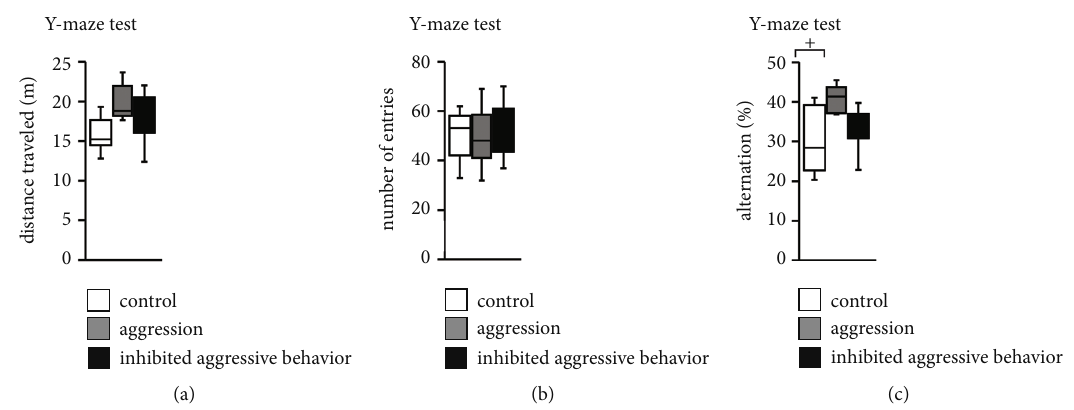
Figure 4: Performance of aggressive behavior-inhibited mice in the Y-maze test. Total distance traveled (a), total number of arm entries (b), and percentage of alternations (c). Data are presented as box plots (a) – (c). * p < 0 : 05 and + p < 0 : 1 . (a) – (c) Control group: n = 7 , aggression group: n = 7 , and inhibited aggressive behavior group: n = 7